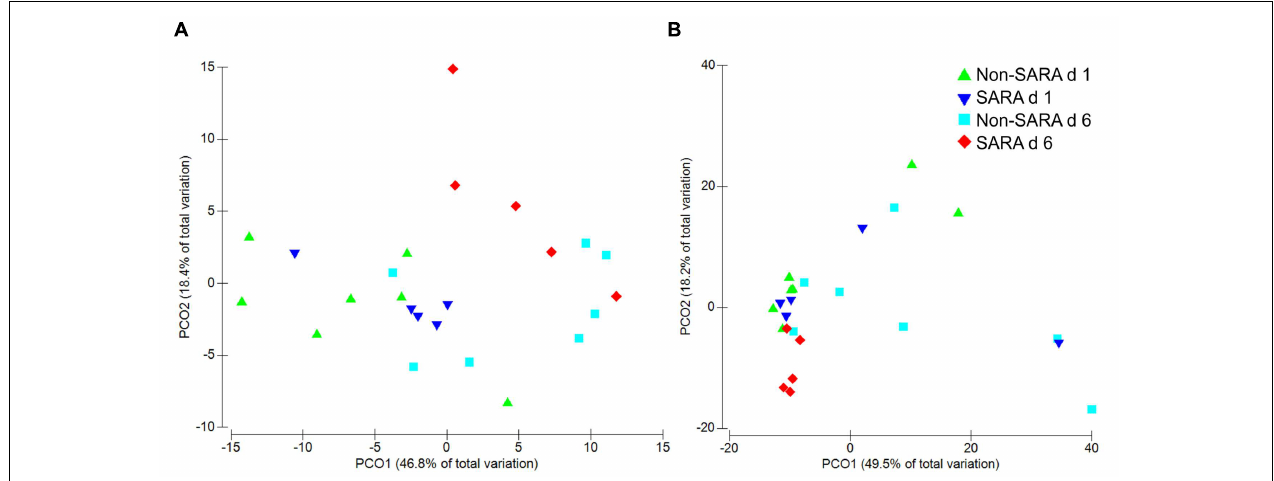
FIGURE 1 | Principal coordinate analysis (PCoA) of beta-diversity in the liquid (A) and solid fraction (B) using Bray–Curtis similarity. Analysis by PERMANOVA revealed a day effect ( P = 0.003), but no effect of SARA grouping (SG; P = 0.60) and SG × day ( P = 0.18) was observed in the liquid fraction. In the solid fraction, PERMANOVA analysis indicated no effect of day ( P = 0.19), SG ( P = 0.83), or SG × day ( P = 0.43).